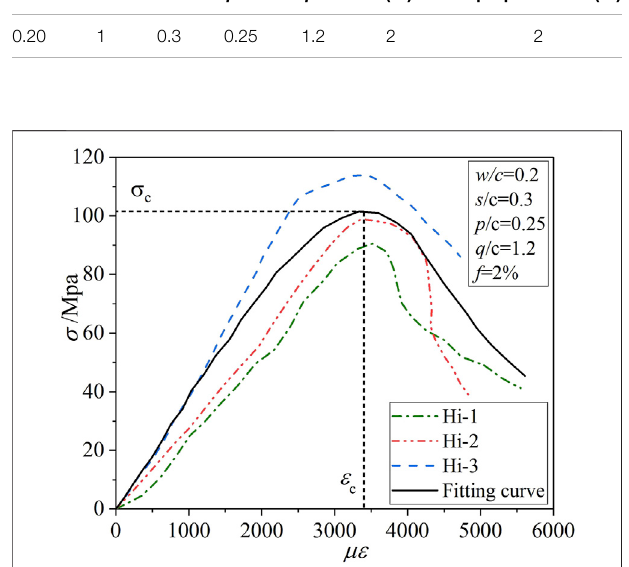
FIGURE 11 | Comparison of fi tting stress-strain curve and test curves.